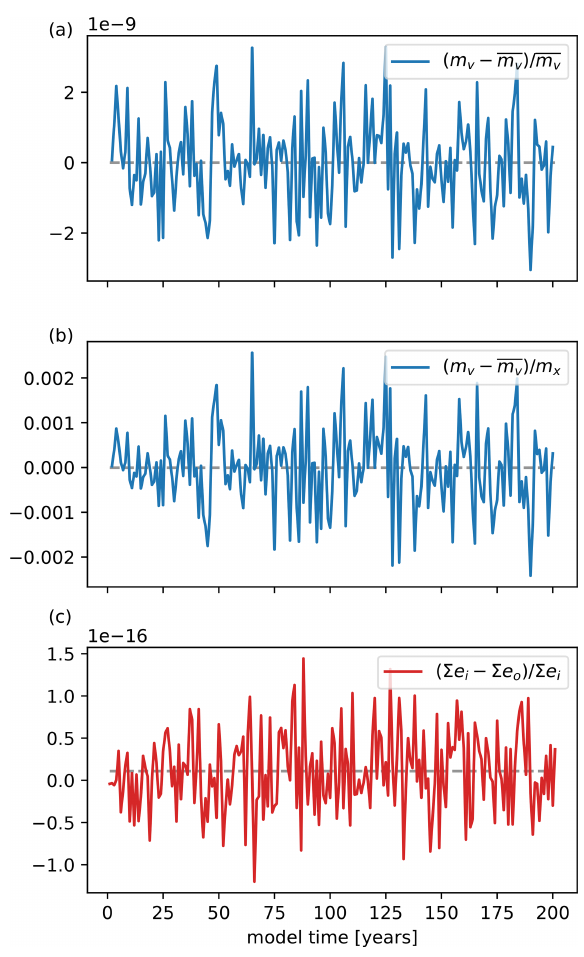
Figure 9. Mass and energy conservation. (a) Relative error of vir- tual mass progression in the coupled ice–ocean system which ex- cludes mass changes applied through surface fluxes and the internal model drift of the coarse grid MOM5–SIS set-up. (b) A comparison of virtual mass fluctuations to the mass exchanged between ocean and land ice components ( m x ). (c) Relative error through remap- ping energy flux from the PISM to MOM5 grid, where e i and e o describe the transferred energy fields (unit W) on the land ice and ocean grid respectively. (cid:54)e is the spatially aggregated energy over the whole grid